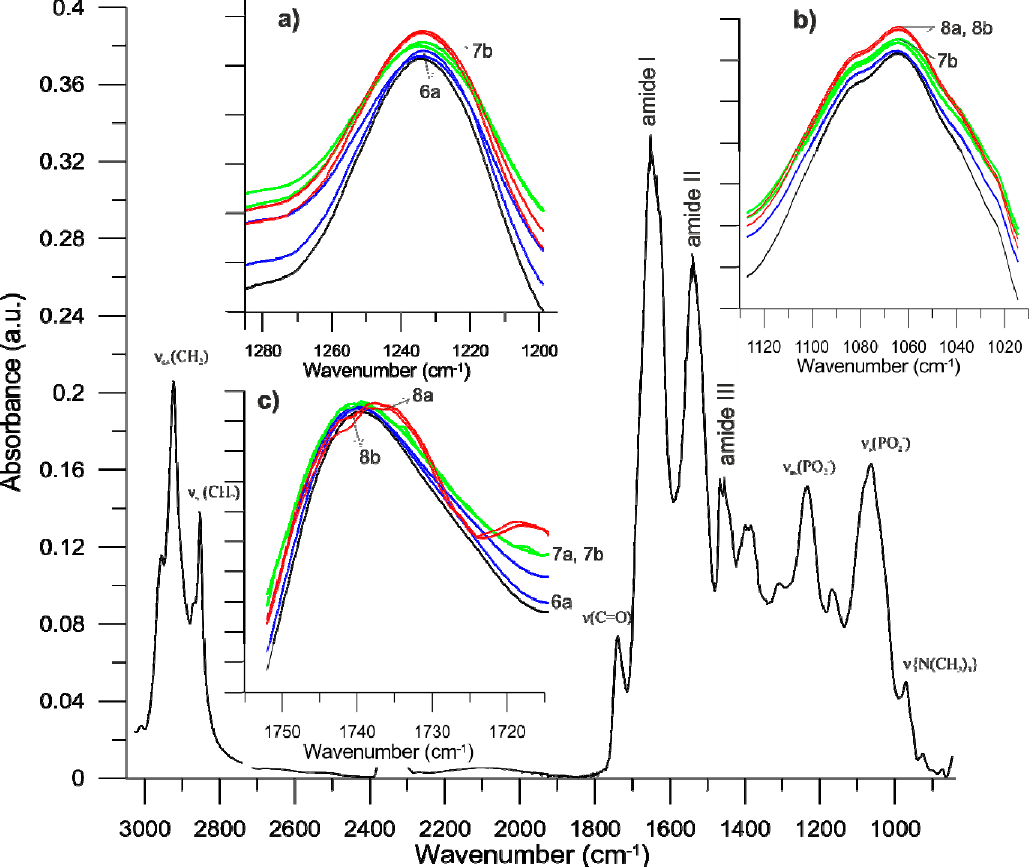
Figure 5. FT-IR spectra of erythrocyte membrane RBCMs (black lines) and of RBCMs modified with lactones (blue lines— 6a and 6b , green lines— 7a and 7b , red lines— 8a and 8b ); ( a ) phosphate band I (asymmetric vibration), ( b ) phosphate band II (symmetric vibration), ( c ) carbonyl band.